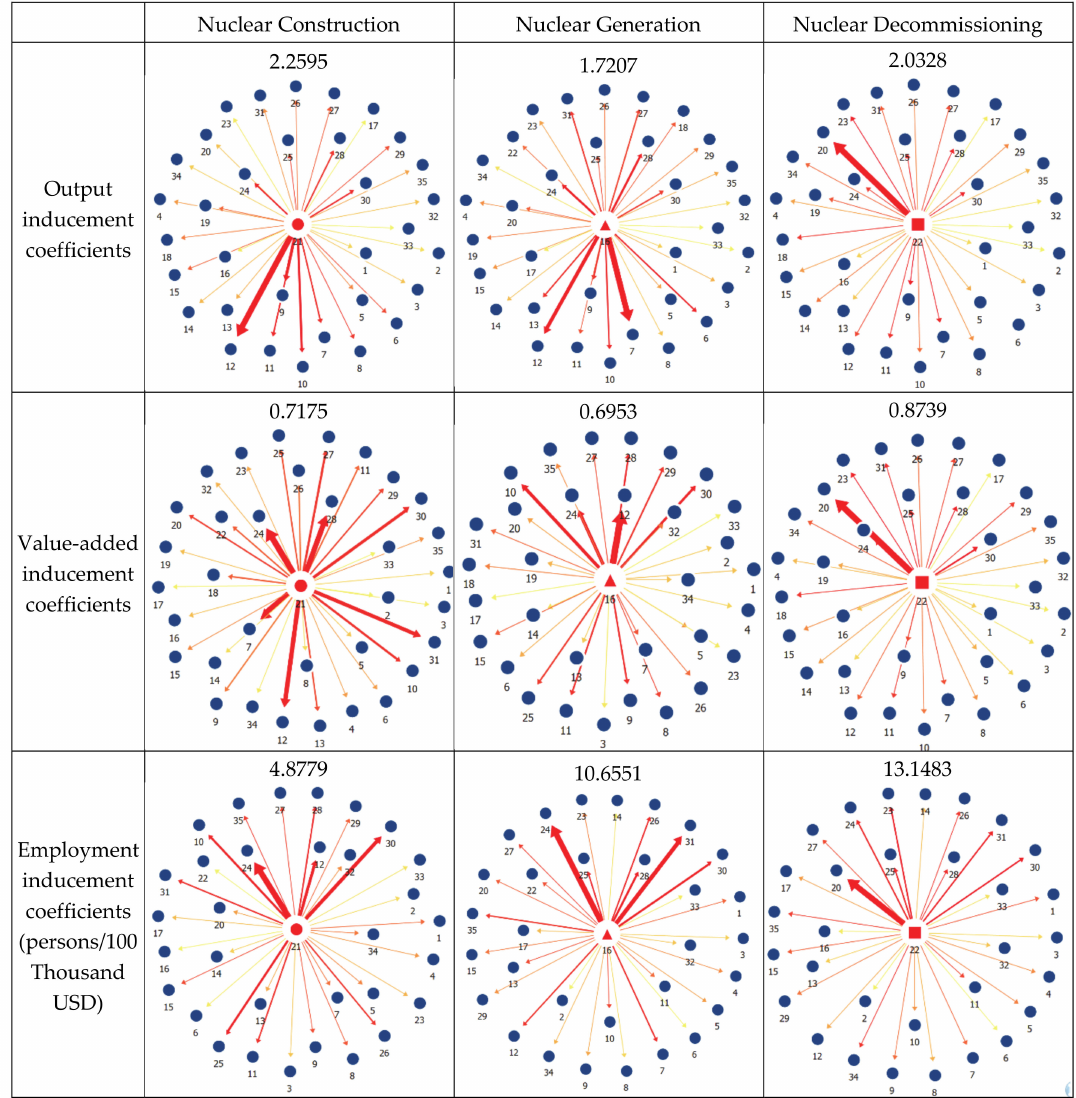
Figure 3. Output, value-added, and employment inducement coe ffi cients by nuclear power industry sector. (Note: Node numbers nodes refer to sectoral IDs. The links illustrate the relative e ff ects of a unit increase of final demand for nuclear power industry sectors. The links are di ff erentiated by width and color: when the increased final demand has a stronger e ff ect, the link is thicker and bright